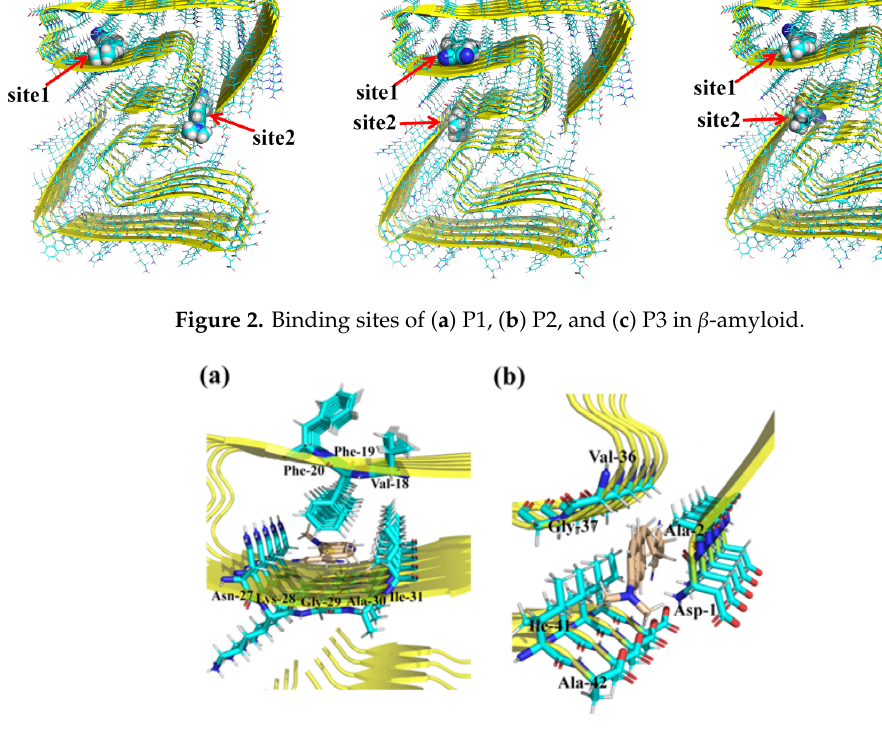
Figure 3. Binding details of P1 in ( a ) site1 and ( b ) site2 in β ‐ amyloid. Table 1. Energy parameters (in kcal/mol) and inhibition constant (in nM) for P1, P2, and P3 in various binding sites in ‐ amyloid.